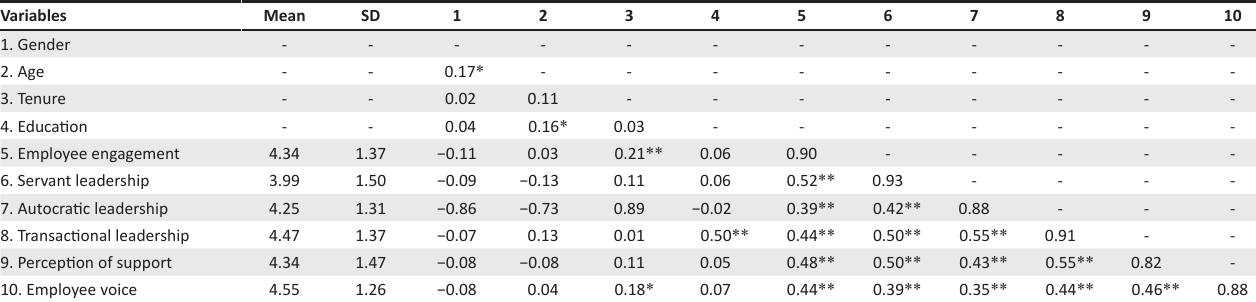
TABLE 4: Descriptive statistics, alpha coefficient and correlations.